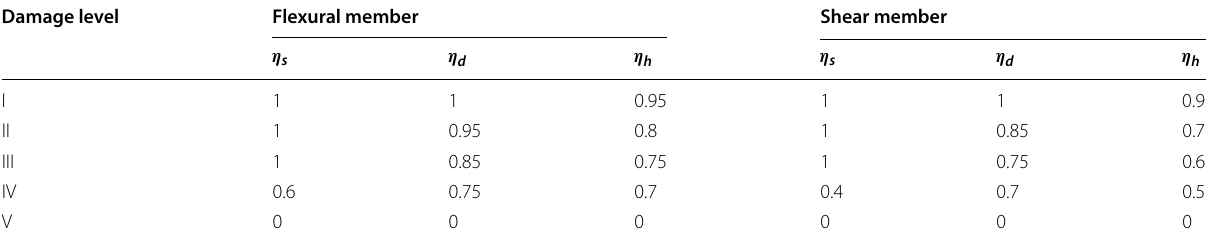
η s is the reduction factor of strength; η d is the reduction factor of deformation; η h is the reduction of damping ratio.